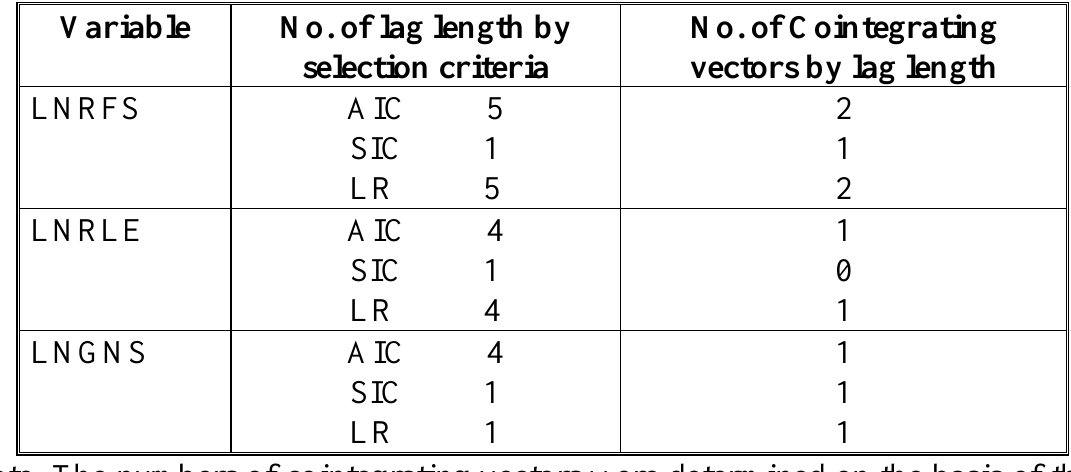
No. of Cointegrating vectors by lag length